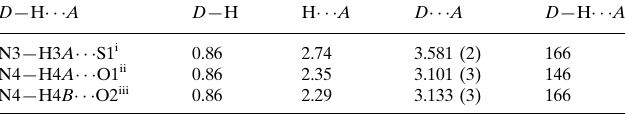
Hydrogen-bond geometry (A˚ , (cid:2)